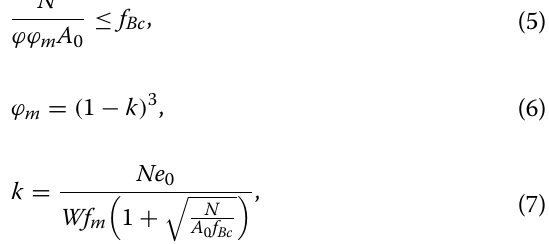
Fig.15 FEA model of column